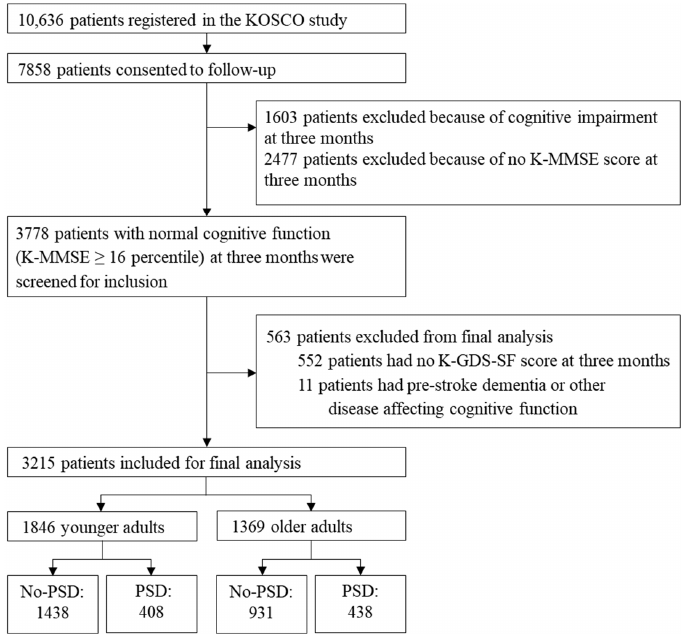
Figure 1. Flow chart of participant enrollment. KOSCO, Korean Stroke Cohort for Functioning and Rehabilitation; K-MMSE, Korean version of the Mini-Mental State Examination; K-GDS-SF, Korean Geriatric Depression Scale Short Form; PSD, post-stroke depression.